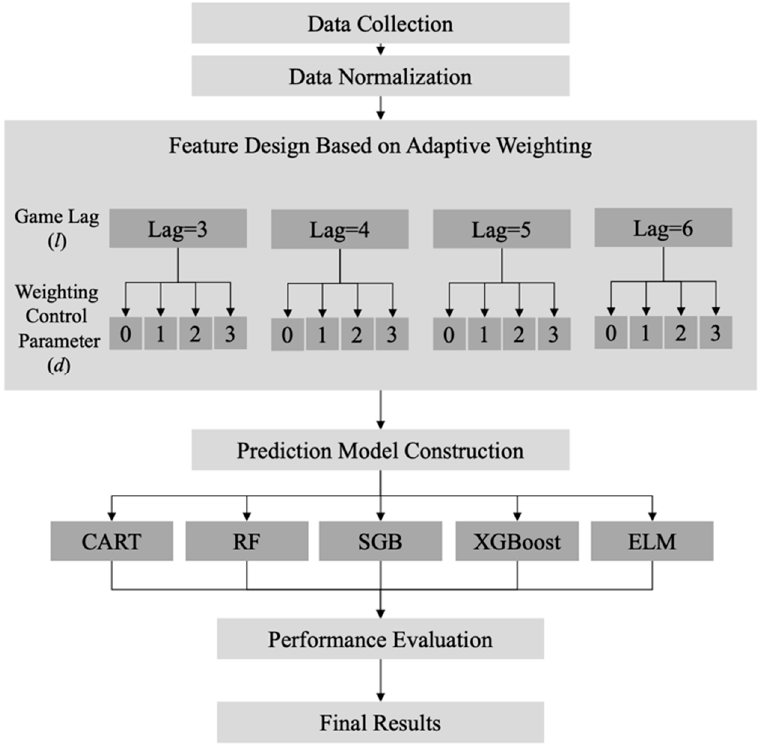
Figure 1. Flowchart of the proposed basketball game score prediction process.